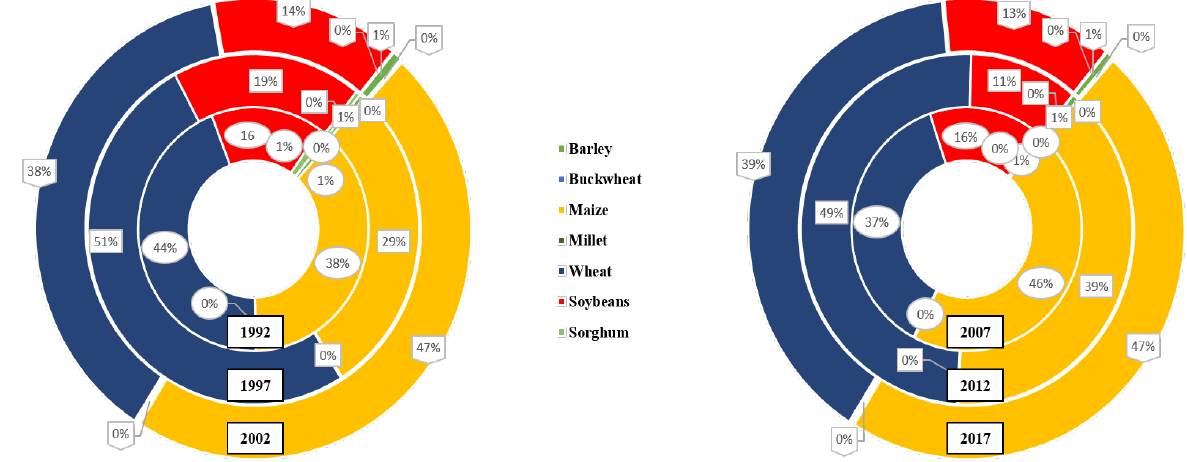
Figure 3. Product structure of grain virtual water flows into South Korea (1992–2017).